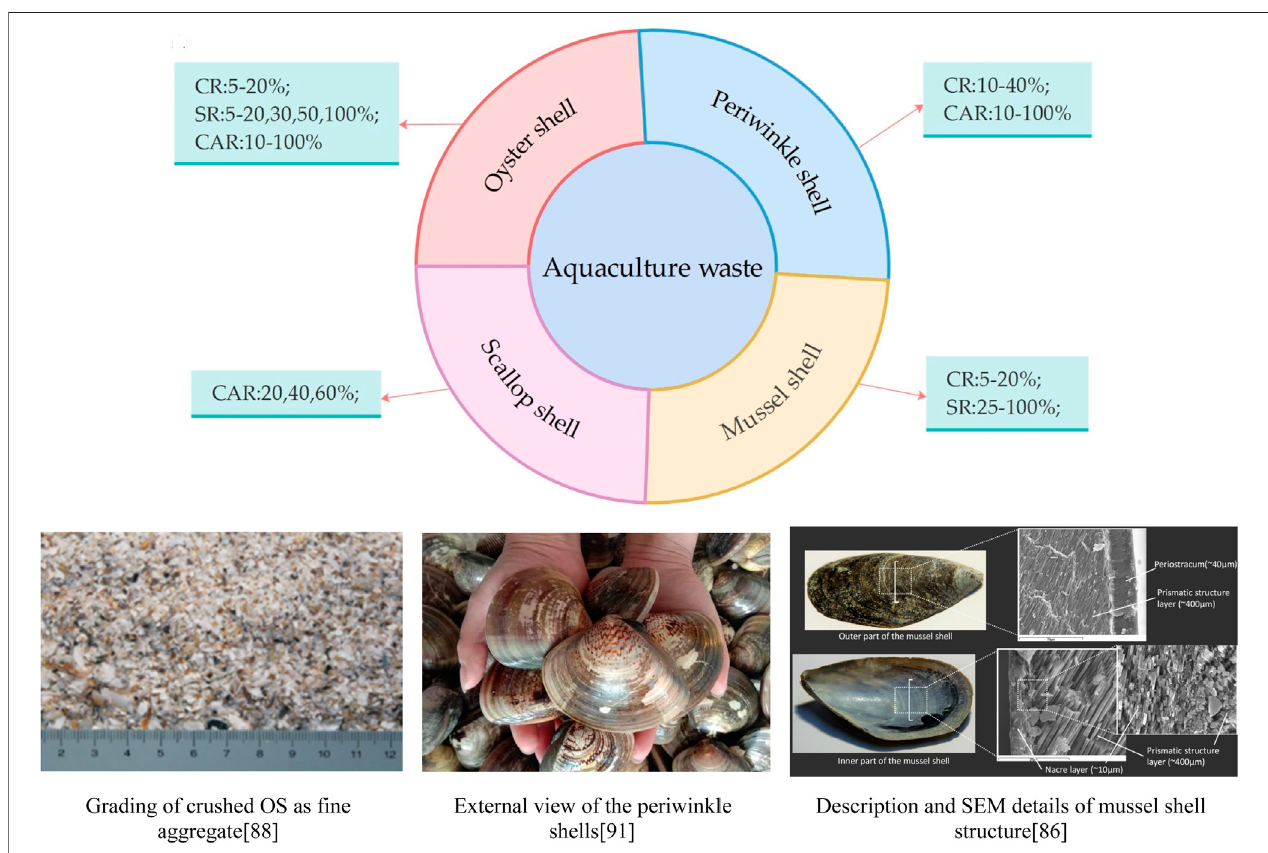
FIGURE 12 | Substitution and mixing amount of aquaculture waste in concrete in other